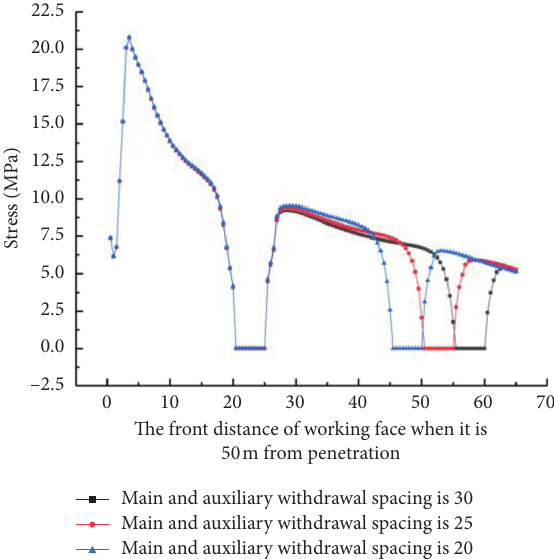
Figure 12: Vertical stress curve when Panel 31113 is 20m from